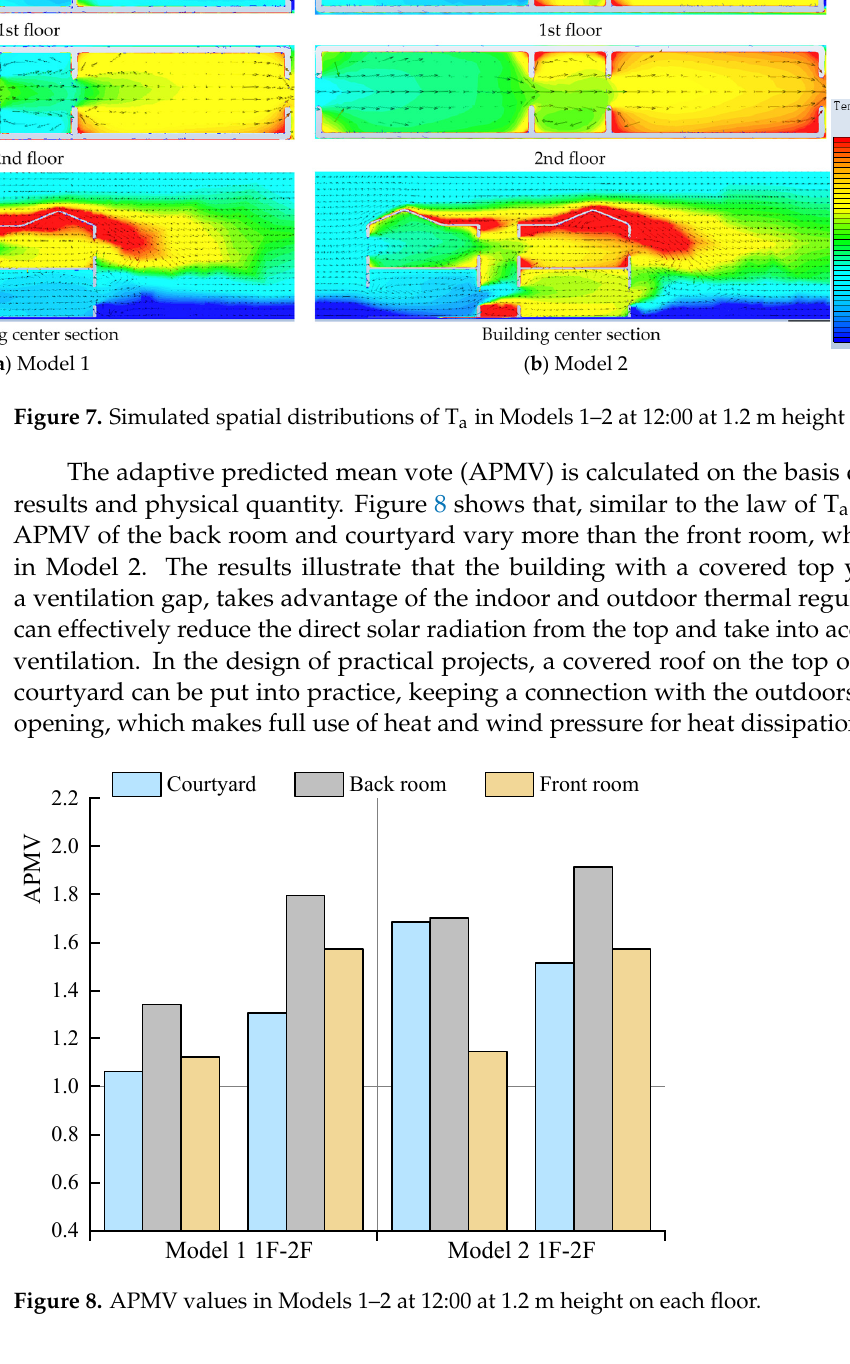
Figure 8. APMV values in Models 1–2 at 12:00 at 1.2 m height on each floor.